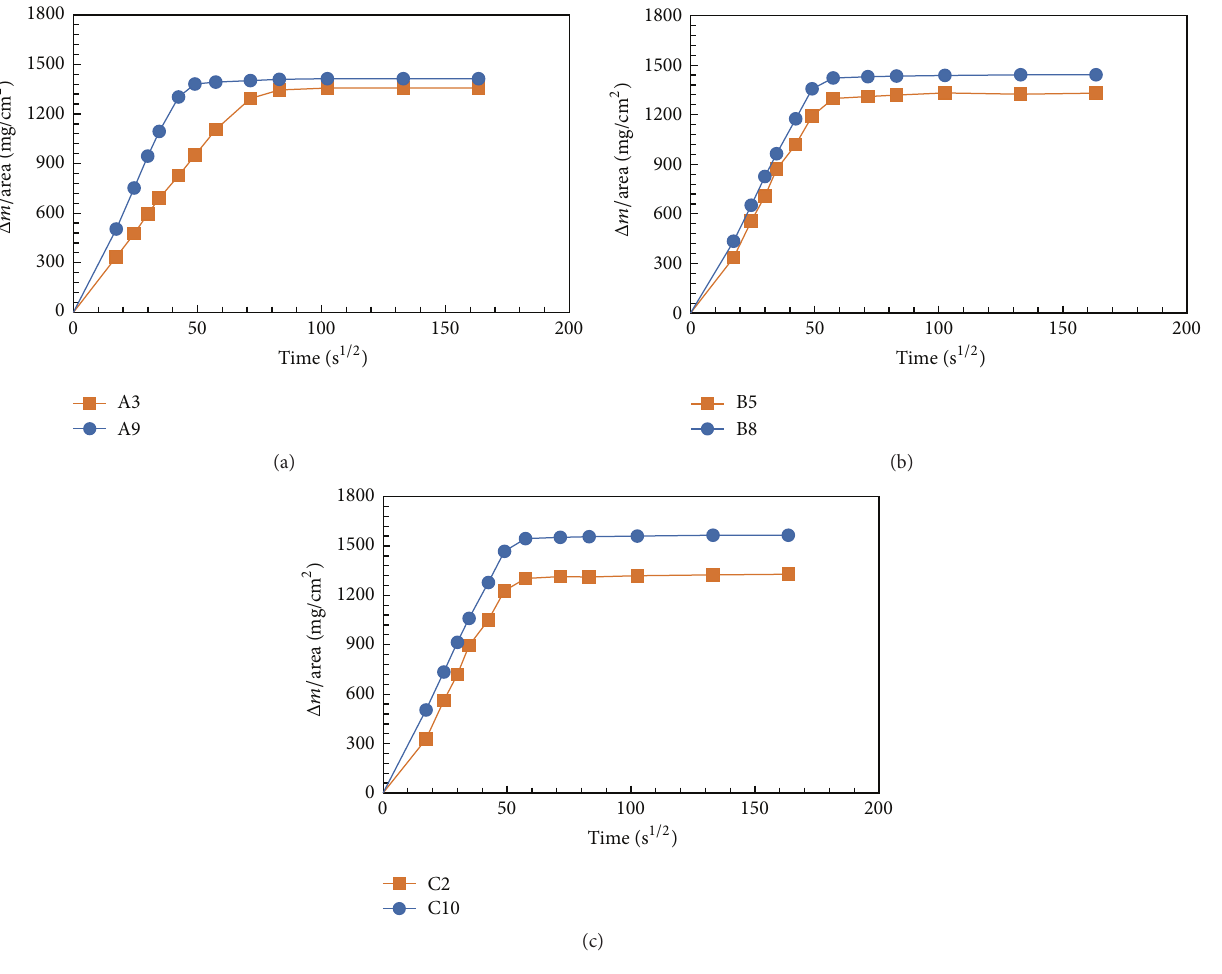
Figure 3: Maximum and minimum sorptivity for systems A, B, and C.